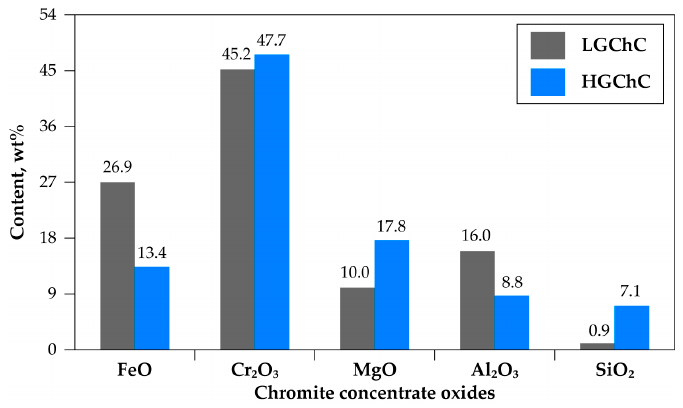
Figure 3. Chemical composition of the chromite concentrate samples.